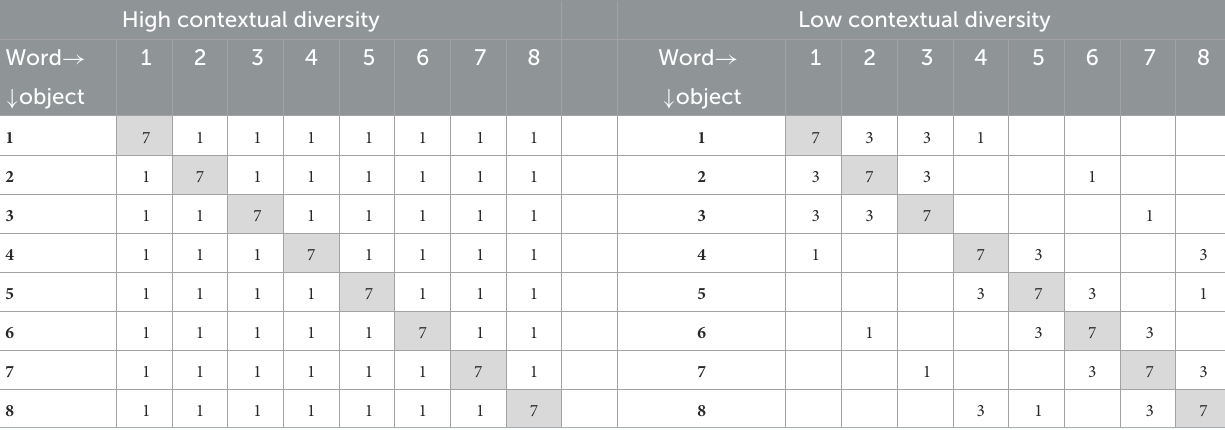
Table 2 for the combinations of word–referent pairs in the two familiarization